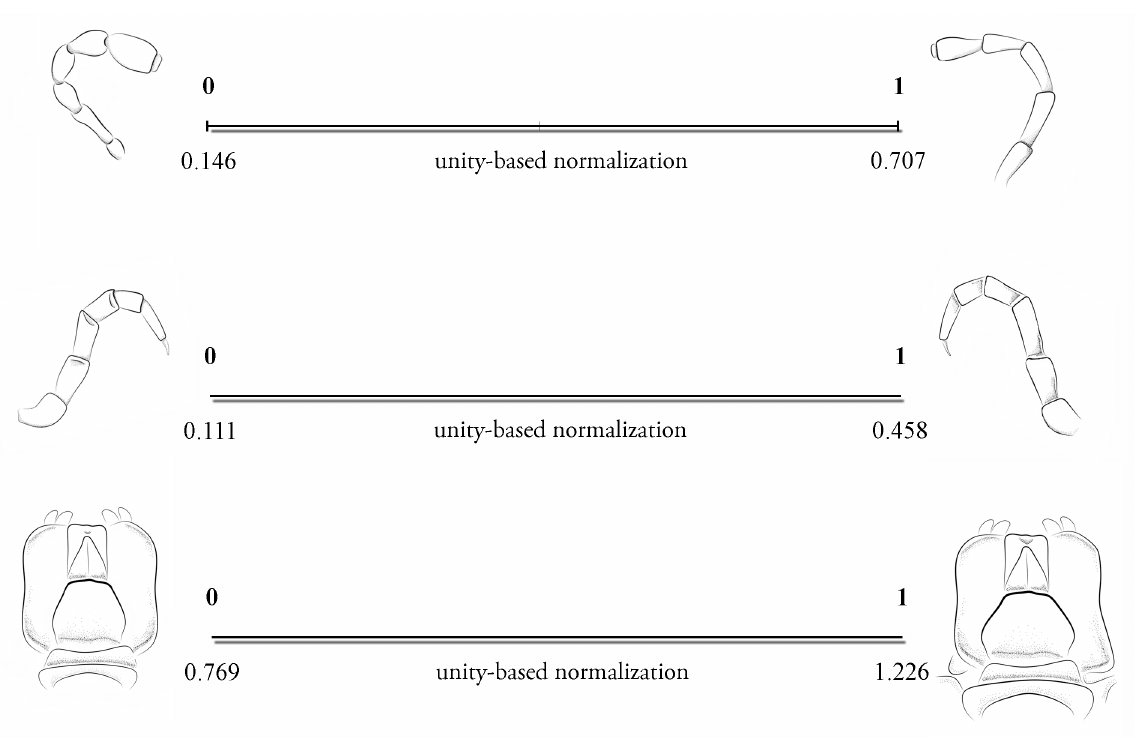
Fig. 3 . Transformation of the continuous characters of antennae, midleg pairs, and shape of mentum (chars. 1–3) by unity-based normalization